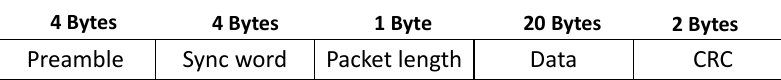
Figure 9. Packet format used in outdoor measurements.